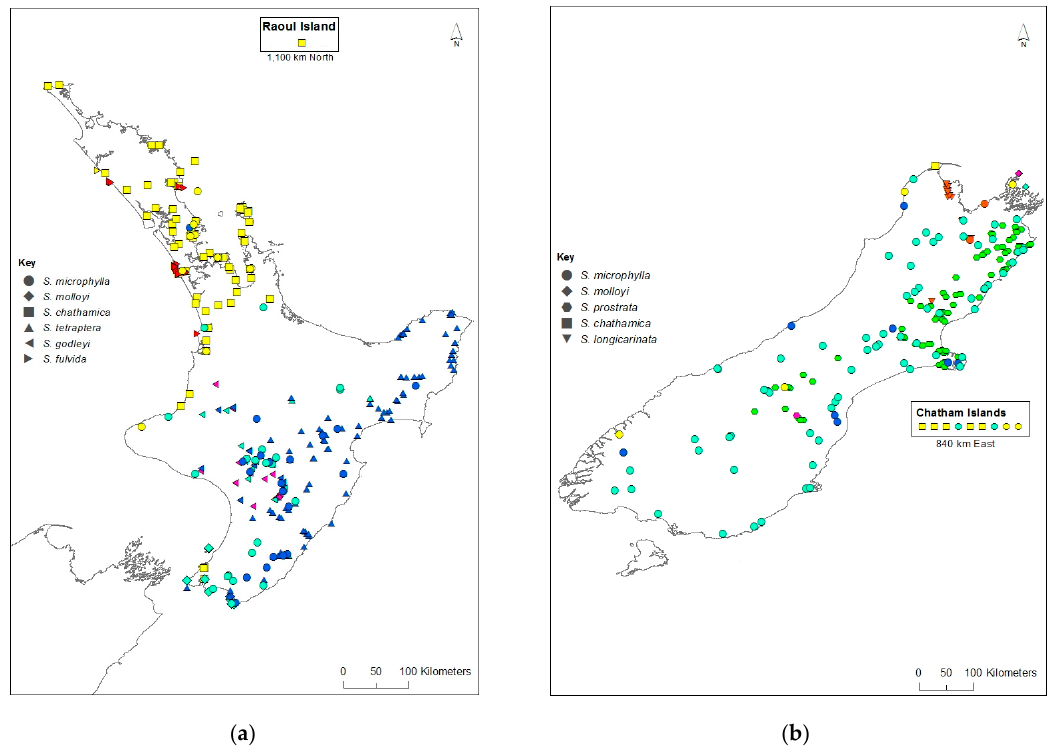
Figure 3. Distribution of Sophora species in New Zealand. ( a ) North Island (inset Raoul Island); ( b ) South Island (inset Chatham Islands). Each species is represented by a different shaped symbol. The symbol colours correspond with the colours in the Structure plot (see Figure 2).